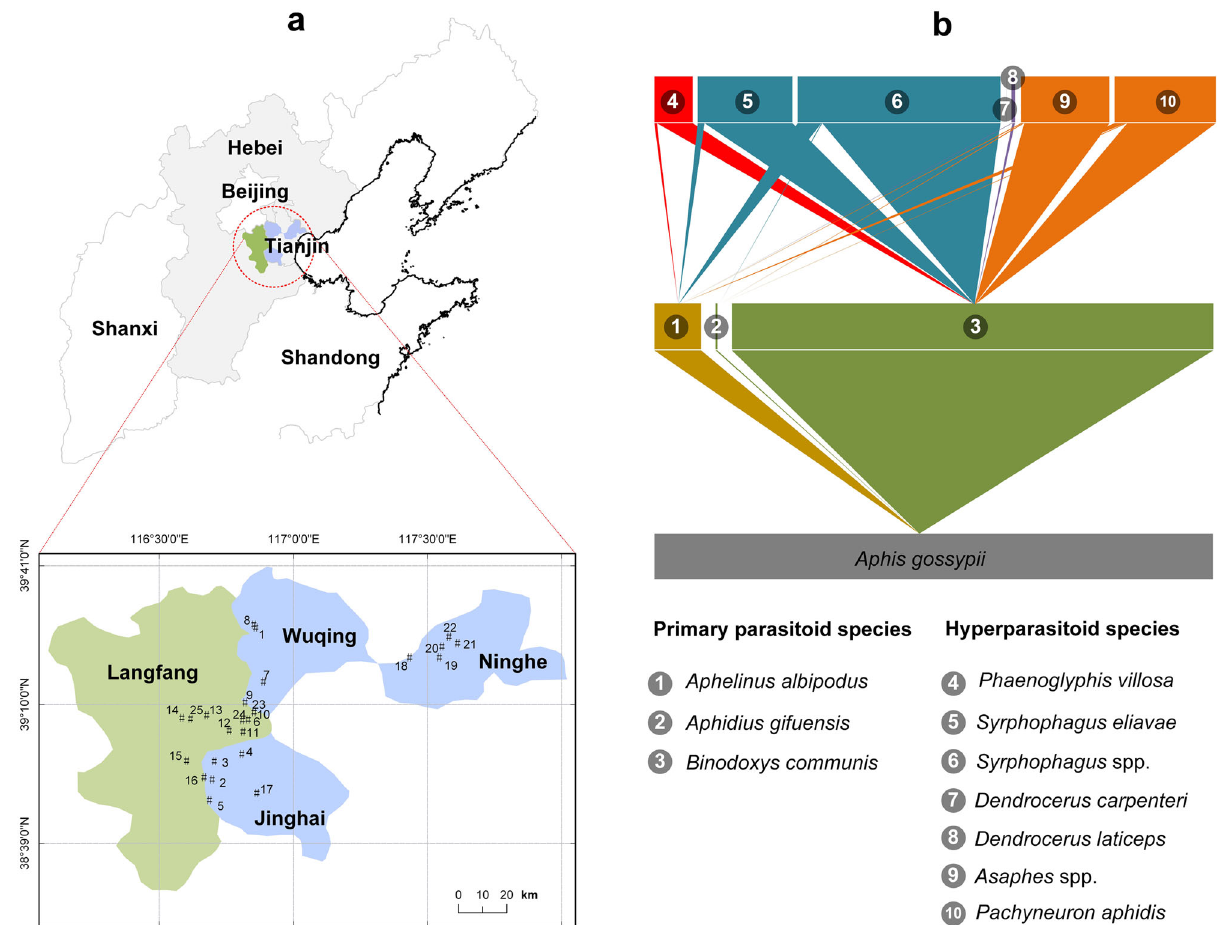
Fig. 1 Geographic distribution of study sites in northern China and aphid-primary-hyperparasitoid tri-trophic food web. From 2014 to 2016, a total of 25 sites were identi fi ed across four geographic regions in northern China ( a ). b Diagrams the overall quantitative food webs including three trophic levels, with the lowest level (gray bar) comprising herbivorous hosts, i.e., the cotton aphid Aphis gossypii . Species numbered 1 – 3 are the primary parasitoids (middle trophic level): Aphelinus albipodus , Aphidius gifuensis and Binodoxys communis ; and 4 – 10 are the hyperparasitoid species (upper trophic level): Phaenoglyphis villosa , Syrphophagus eliavae , Syrphophagus spp., Dendrocerus carpenteri , Dendrocerus laticeps , Asaphes spp., Pachyneuron aphidis . Species that are marked with the same color belong to the same family. The width of a given triangle re fl ects the relative proportion of linkage